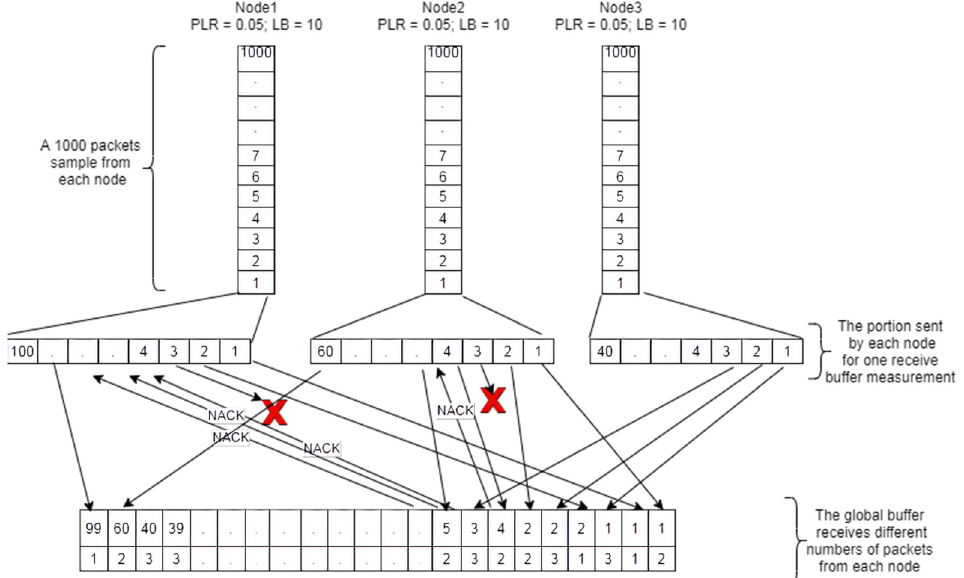
Figure 1. Multi-source data transmission schema for MS-AL-ARQ. PLR: Packet Loss Ratio; LB: Lost Burst.